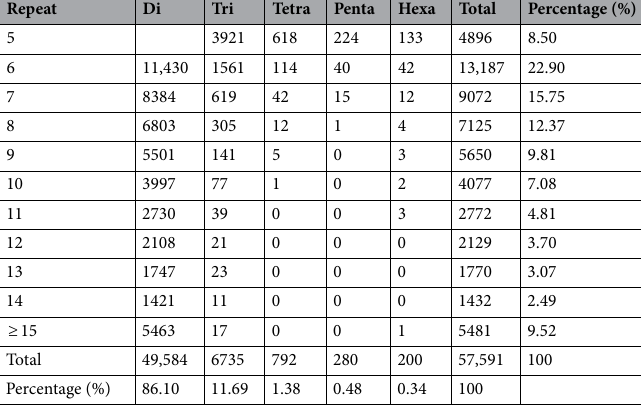
Table 2. The distribution of microsatellites based on the number of repeat